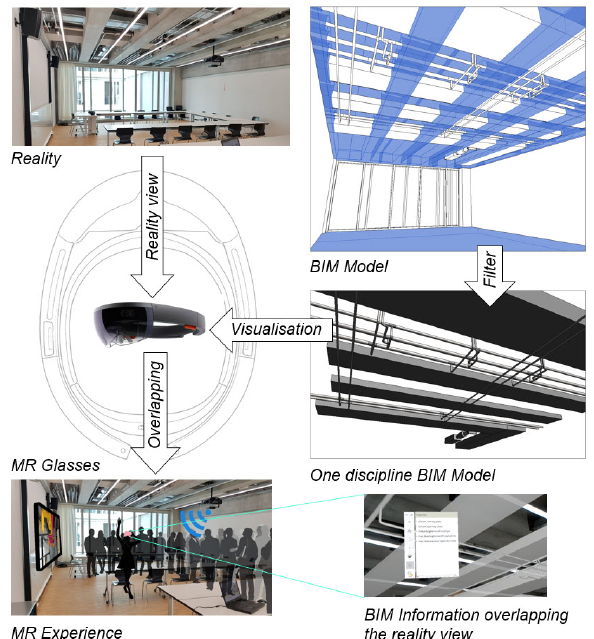
Figure 9. Mixed reality workflow: From BIM model of the campus to an interactive visualisation of object properties for FM use